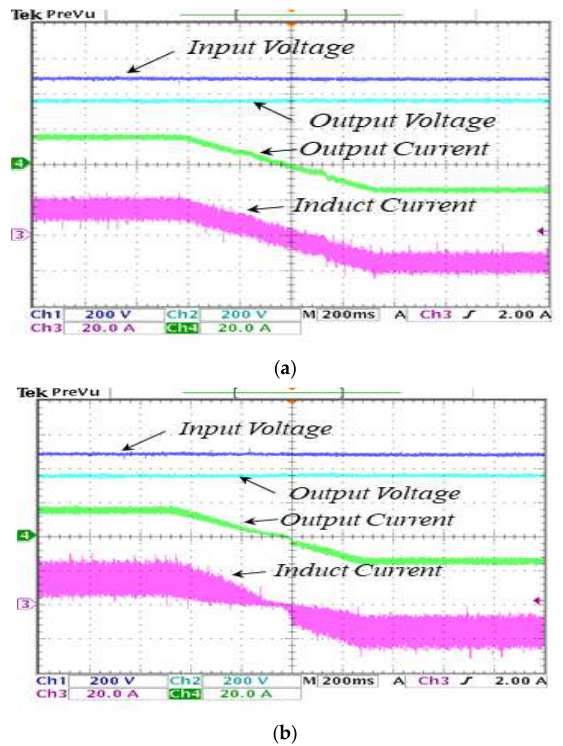
Figure 16. Bidirectional power transfer characteristic test. ( a ): Experimental results of conventional converters. ( b ): Experimental results of the proposed converter.